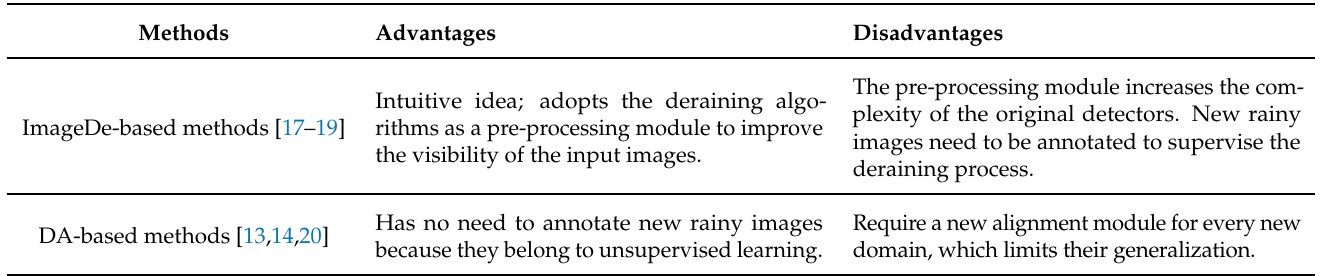
Table 1. Summary of the advantages and disadvantages of object detection under rainy weather